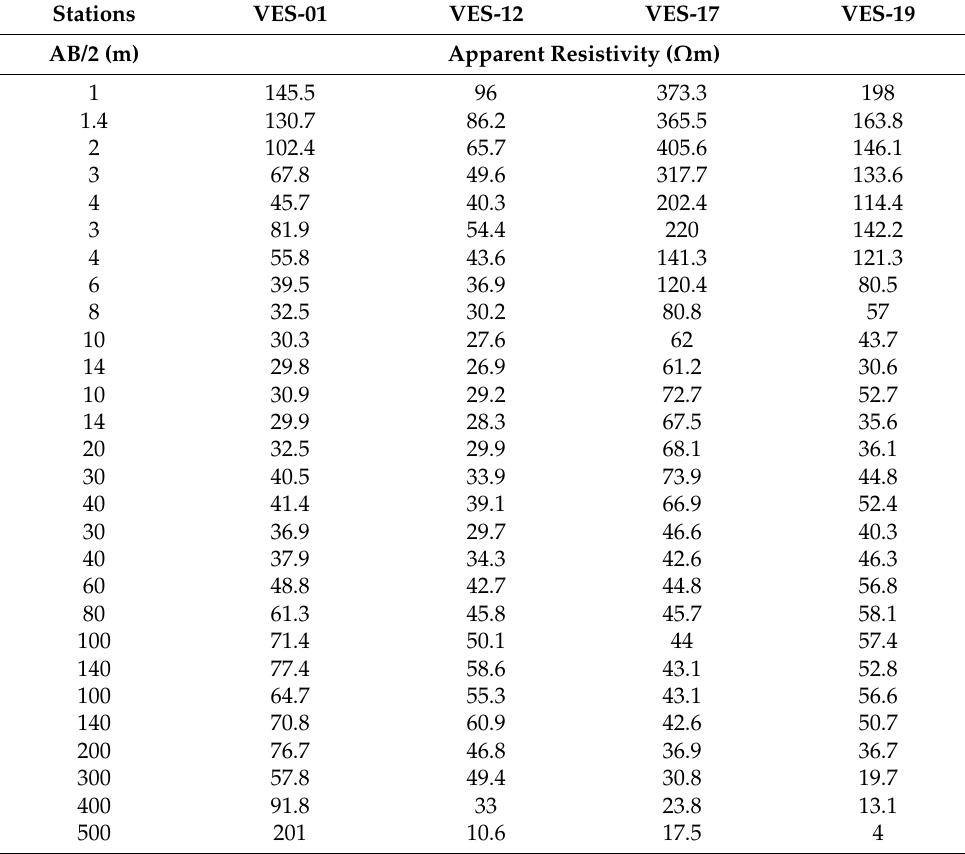
Table 1. Example of raw electrical resistivity (DC) data (apparent resistivity and AB/2) at some selected VES stations along the main